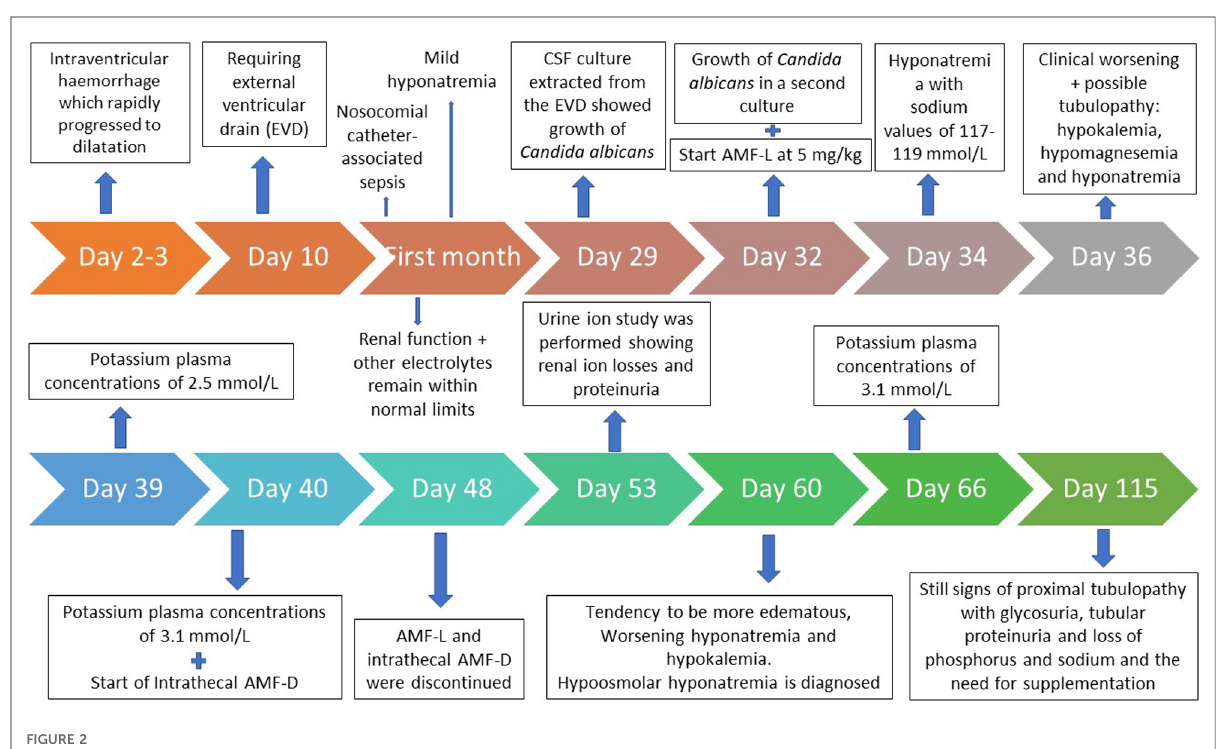
FIGURE 2 Investigations date wise and fl owchart of patient